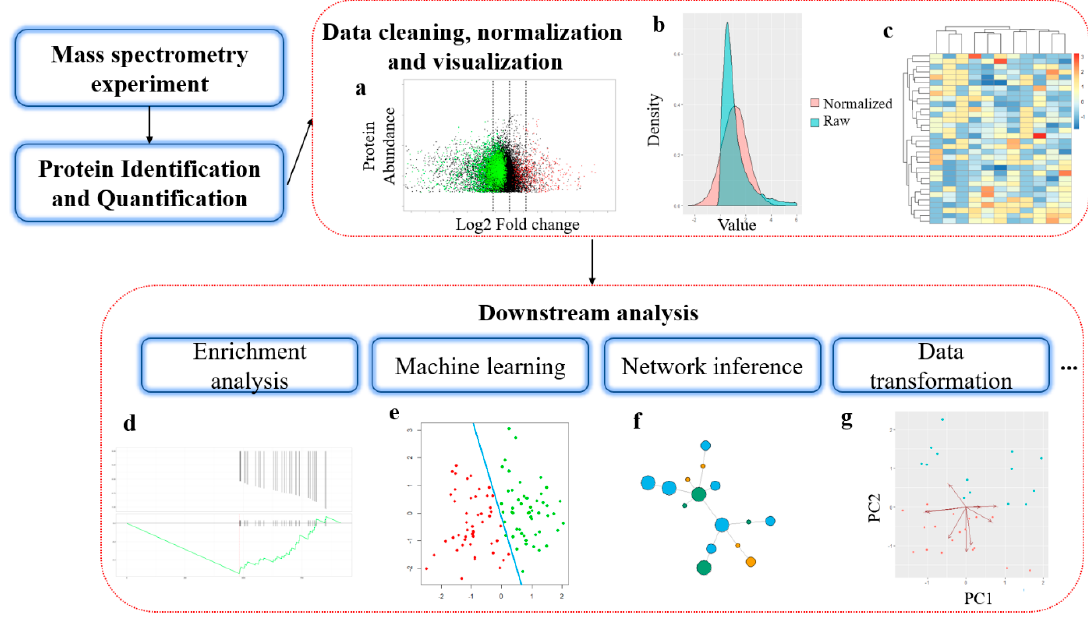
Figure 1. General workflow of bioinformatics analysis in mass spectrometry-based proteomics. ( a ) MA-plot from protein differential abundance analysis. X-axis is the log2 transformed fold change and Y-axis is the average protein abundance from replicates. ( b ) Distribution of protein abundance data before and after normalization. ( c ) Heatmap for protein abundance with clustering; ( d ) Protein set enrichment analysis, Y-axis in the above plot shows the ranked list metric, and in the bottom plot shows the running enrichment score. X-axis is the ranked position in protein list. ( e ) Machine learning-based sample clustering. ( f ) Illustration of a network inferred from proteomics data. ( g ) Dimensionality reduction of proteomics expression profile.